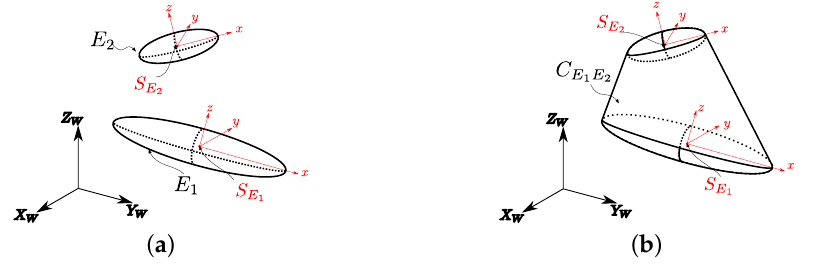
Figure 6. Example of cushion C E , arbitrarily oriented and positioned ellipsoids ( E 1 and E 2 ) in 1 E 2 space with convex hull operation between E 1 and E 2 . ( a ) Ellipsoids E 1 and E 2 . ( b ) Cushion C E between ellipsoids E 1 and E 2 .